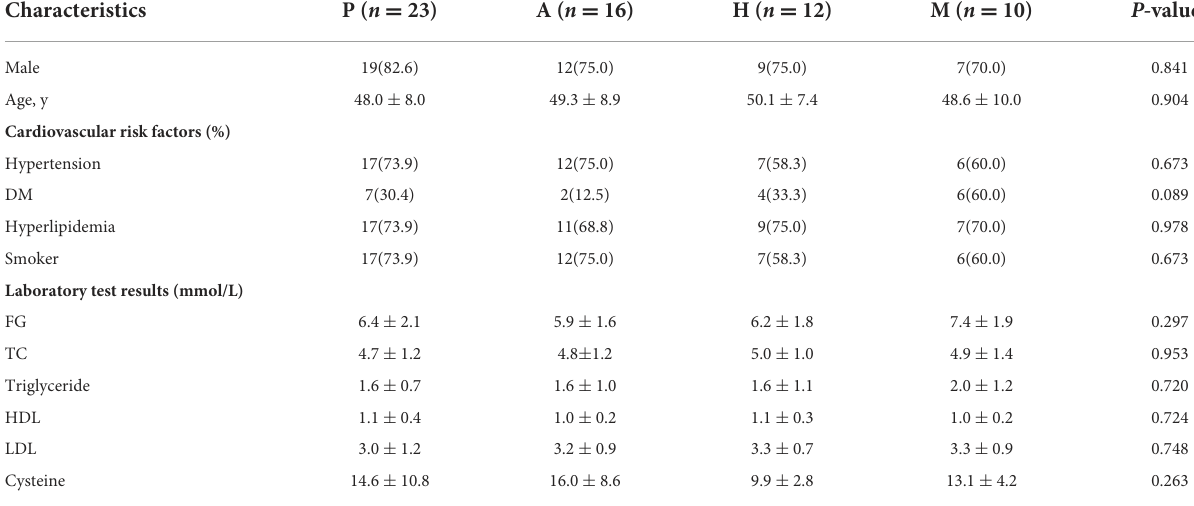
TABLE 1 Baseline demographics of the patients.